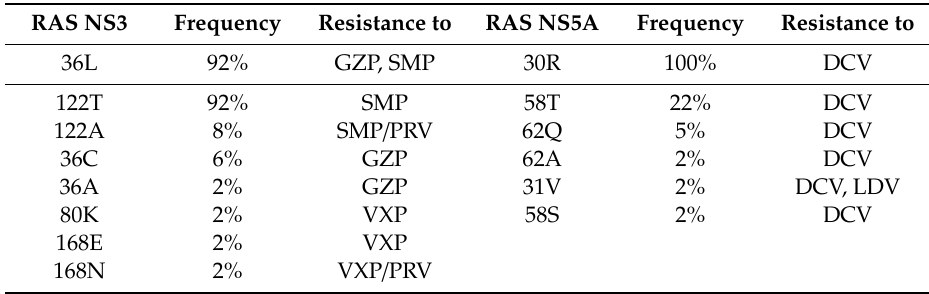
Table 2. RAS frequencies in NS3 and NS5A proteins, using the resistance prediction rules of the Geno2pheno algorithm. GZP: Grazoprevir, VXP: Voxilaprevir, SMP: Simeprevir, DCV: Daclatasvir, LDV: Ledipasvir.